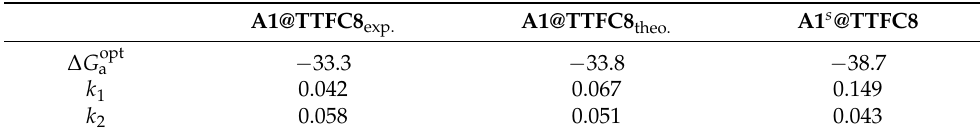
Table 2. Results obtained from the analysis of Equation (3) for A1@TTFC8 and A1 s @TTFC8 , com- puted at the SMD/M06-2X/def2-TZVP level and from experimental values. ∆ G opt a values are given in kJ/mol. k 1 and k 2 are dimensionless. Note that BF − had to be omitted from the analysis 4